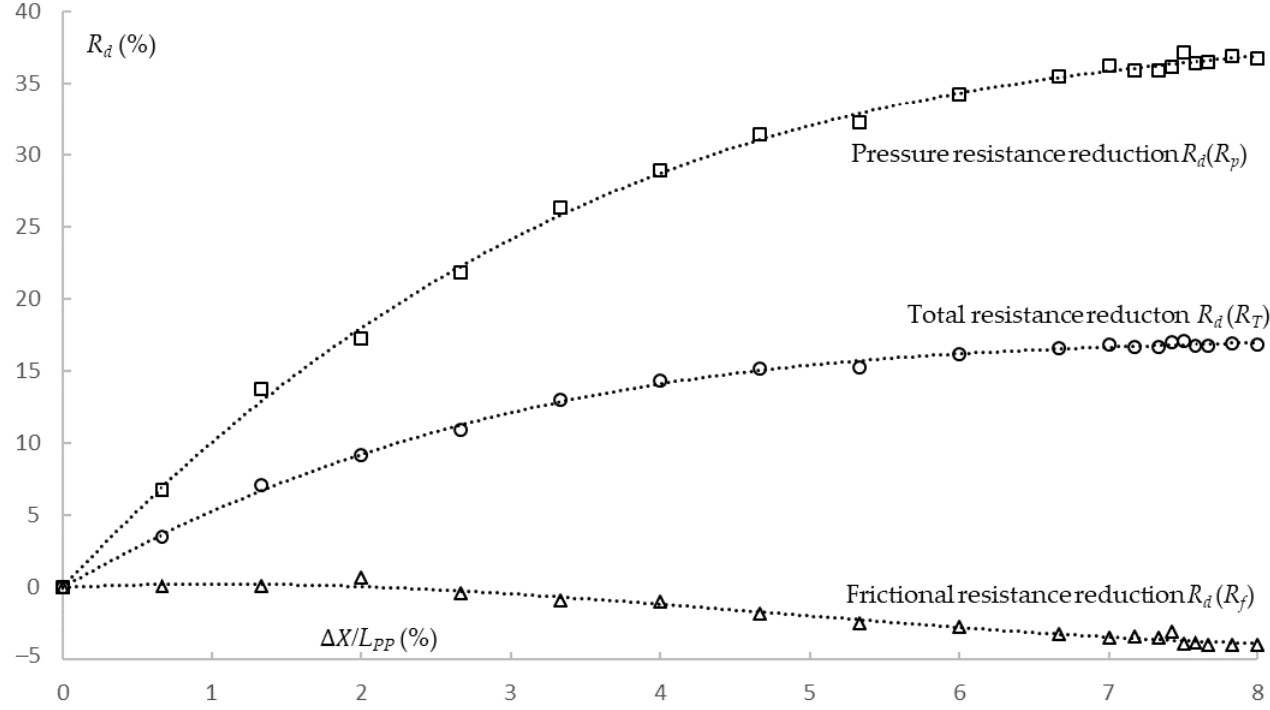
Figure 7. Trend of resistance reduction.